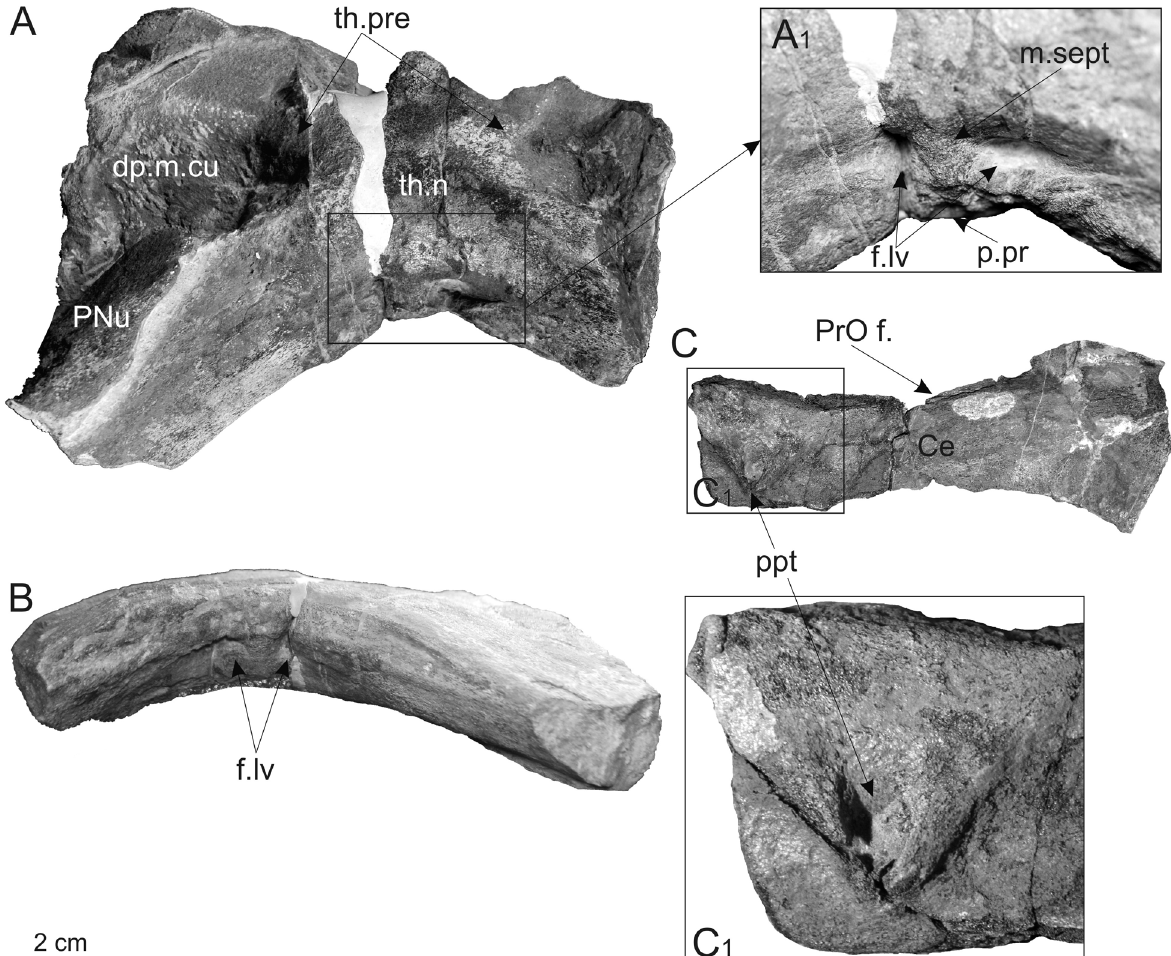
Fig. 4. A , specimen MWG UW ZI/43/0053, visceral view. A1 , magnified fragment of fig. A. B , specimen MWG UW ZI/43/0053, back view. C , specimen Muz. PGI-NRI 1809.II.23, fragment of the pineal and left central plates. C1 , magnified area of the pineal plate marked on C. See Fig. 2 for the explanation of